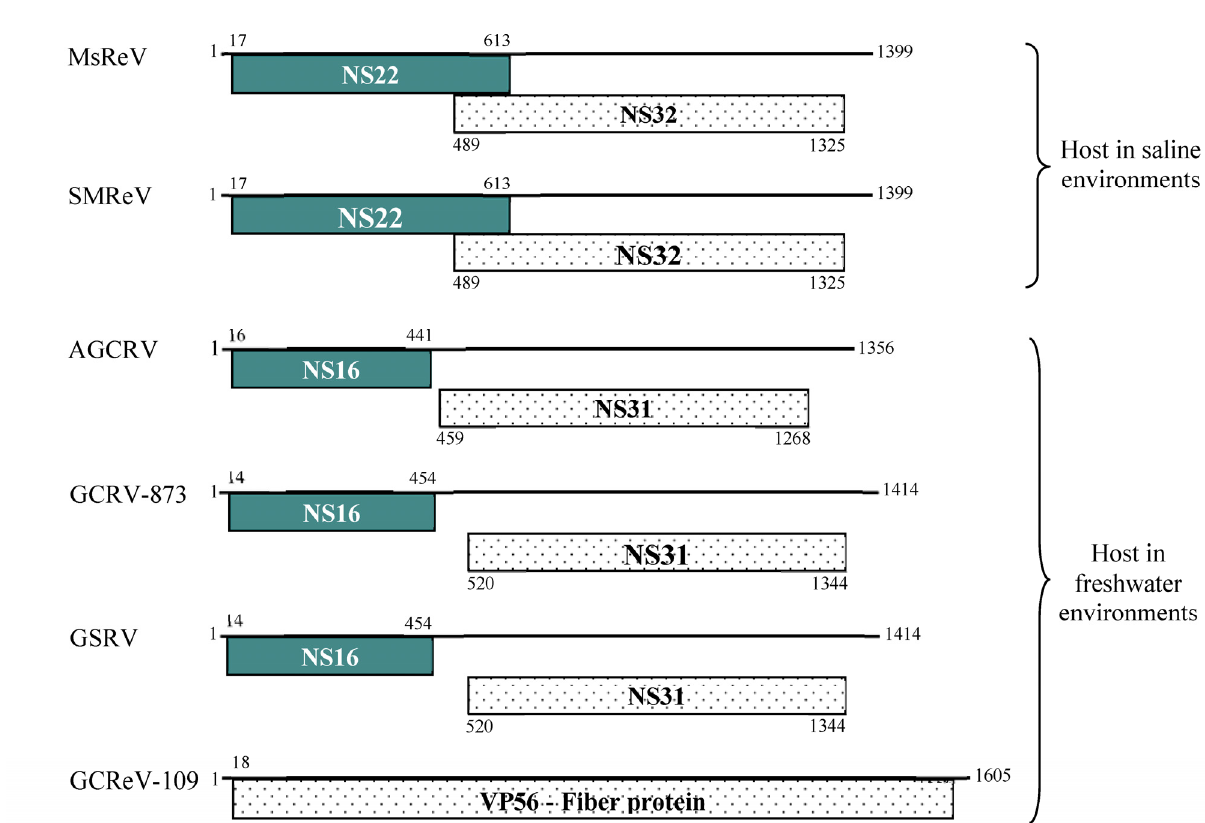
Figure 3. Experimental evidence on the function of MsReV FAST protein NS22. ( a ) Syncytium formation, a characteristic form of cytopathic effect (CPE) induced by MsReV in GCF cell lines at 72 h after infection. Arrows indicate the syncytia. Bar = 200 μ m; ( b ) Fluorescence micrographs of GCF cells transfected with plasmid pEGFP-NS22. The expression of NS22-EGFP induced syncytium formation, while NS22-EGFP was distributed in the fused cells. Bar = 100 μ m; ( c ) A series of recombinant plasmids containing different regions of S7 (5 ′ fragment of MsReV S7 that encodes the NS22), including full NA22-coding gene (1-613), deletions (14-613, 15-613, 17-613) and point mutations (1-613/ ∆ 14, 1-613/ ∆ 18). The putative start site (CUG) is underlined. GCF cells were transfected with the indicated constructs, and stained by Wright-Giemsa staining at 48 h post transfection. Representative images are present at the right. Expression of functional NS22 (1-613, 14-613 and 1-613/ ∆ 14) could lead to the production of syncytia, but the non-functional NS22 (15-613, 17-613 and 1-613/ ∆ 18) did not induce visible changes. Bar = 100 μ m; ( d ) Each S7 genome segment organization and their encoded proteins in the reported aquareoviruses. NS22 ORFs are shown as shaded boxes in MsReV and SMReV, and NS16 ORFs are shown as shaded boxes in AGCRV, GCRV-873, and GSRV. But GCReV-109 lacks the NS22 ORF. Numbers indicate the size of the S7 genome segments and the first and last nucleotides of each ORF.